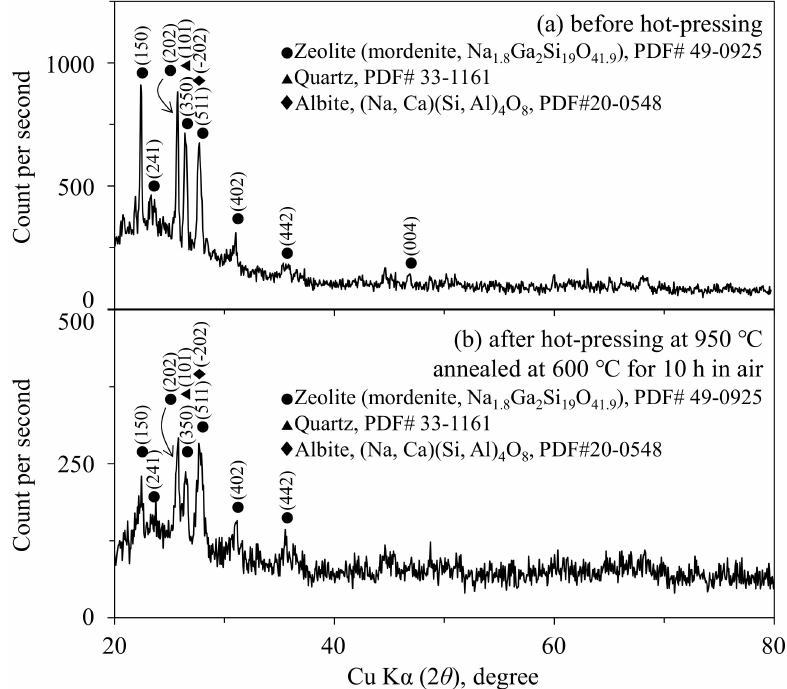
Figure 2. Phases of the 18.2 vol % zeolite–12.4 vol % pore–shirasu glass composite ( a ) before and ( b ) after hot-pressing at 950 ◦ C for 2 h in an Ar